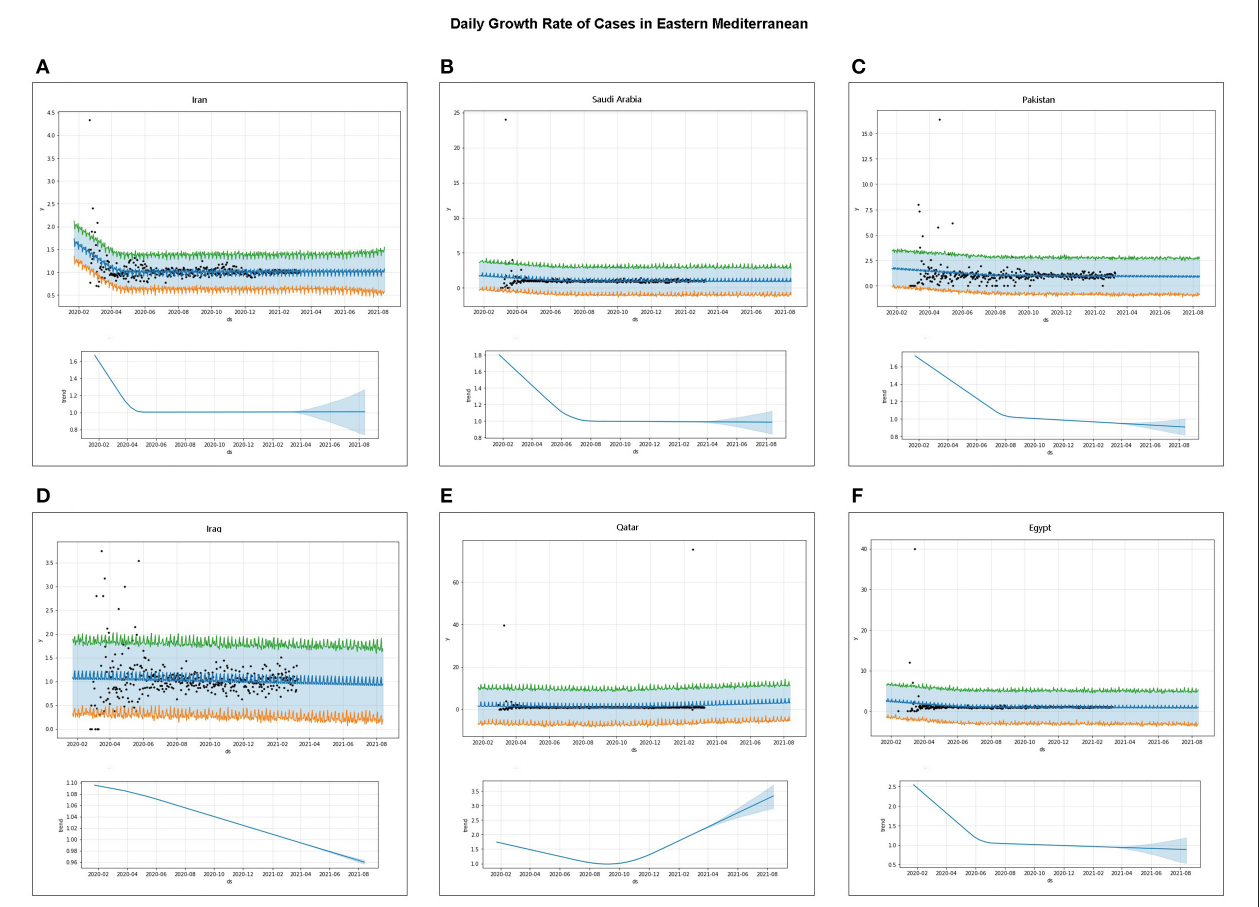
FIGURE 5 | Forecast of trends in daily confirmed cases of the coronavirus disease 2019 (COVID-19) pandemic: (A–F) trends of the daily number of confirmed cases forecast by machine learning in Iran, Saudi Arabia, Pakistan, Iraq, Qatar, and Egypt, respectively—the top panel forecasts the daily number of confirmed cases obtained by machine learning, the bottom panel forecasts the trend of the number of daily confirmed cases, the ds -coordinates in the figure represent the date, and the y -coordinates correspond to the predicted